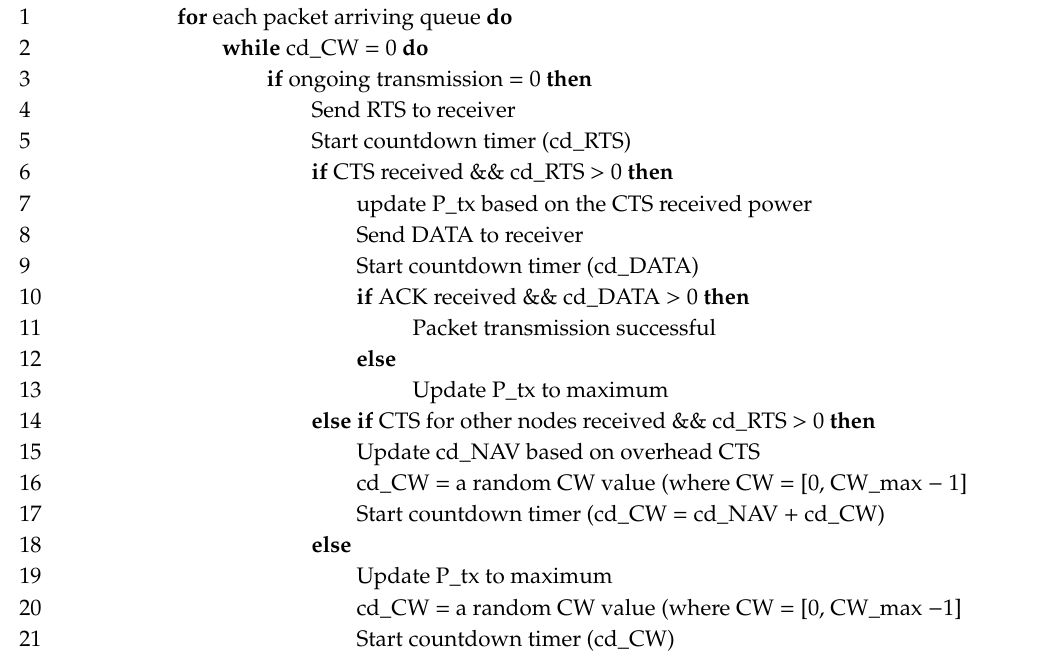
Algorithm 1 VSDH-MAC protocol with power control algorithm. cd_CW is the number of contention window, cd_RTS, cd_DATA are counters for sensor nodes after transmitting RTS and DATA packets respectively, cd_NAV is a counter based on the NAV from the overheard packet, CW_max is the maximum value for contention